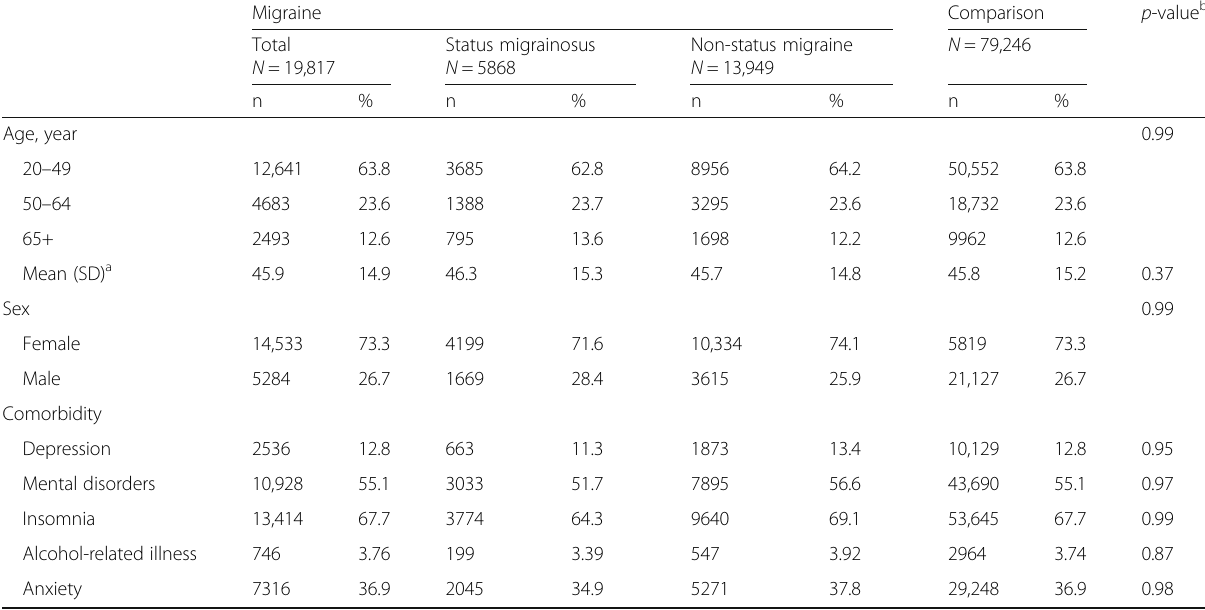
Table 1 Distribution of age, sex, and comorbidities between the migraine and comparison cohorts Migraine